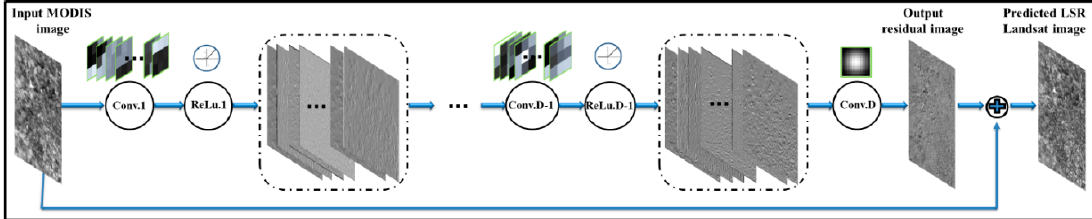
Figure 2. The architecture of the non-linear mapping VDCN, where LSR means low spatial resolution (i.e., the downsampled Landsat image).